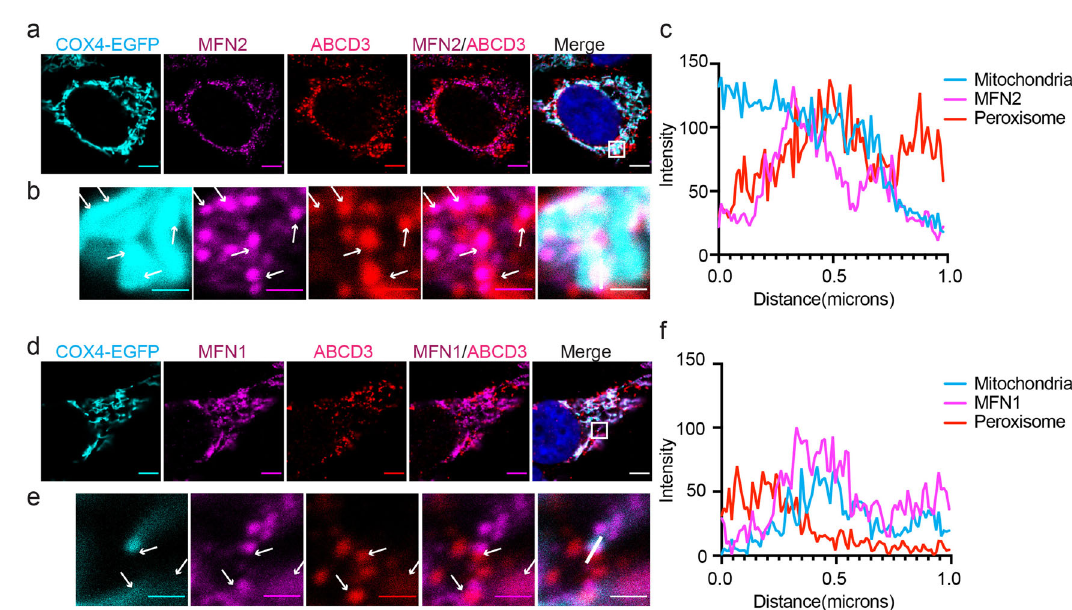
Fig. 5 Endogenous mitofusins locate on the mitochondrion-peroxisome contacting sites. a Immuno fl uorescence images of endogenous MFN2. Confocal microscopy analysis of HeLa cells expressing COX4-EGFP (mitochondria), immunostained for MFN2 (Alexa Fluor 555) and peroxisomal protein ABCD3 (Alexa Fluor 647). Scale bars: 5 μ m. b The zoomed-in images of the white box in ( a ). White arrows point the places where ABCD3 overlaps with MFN. Scale bars: 1 μ m. c Histograms display measured fl uorescence intensity along the white line in the merge panels in b , with the cyan line represents mitochondria, the magenta line represents endogenous MFN2, and the red line represents peroxisome. d – f Immuno fl uorescence images and analysis of endogenous MFN1. Similar experiments were performed as in ( a – c